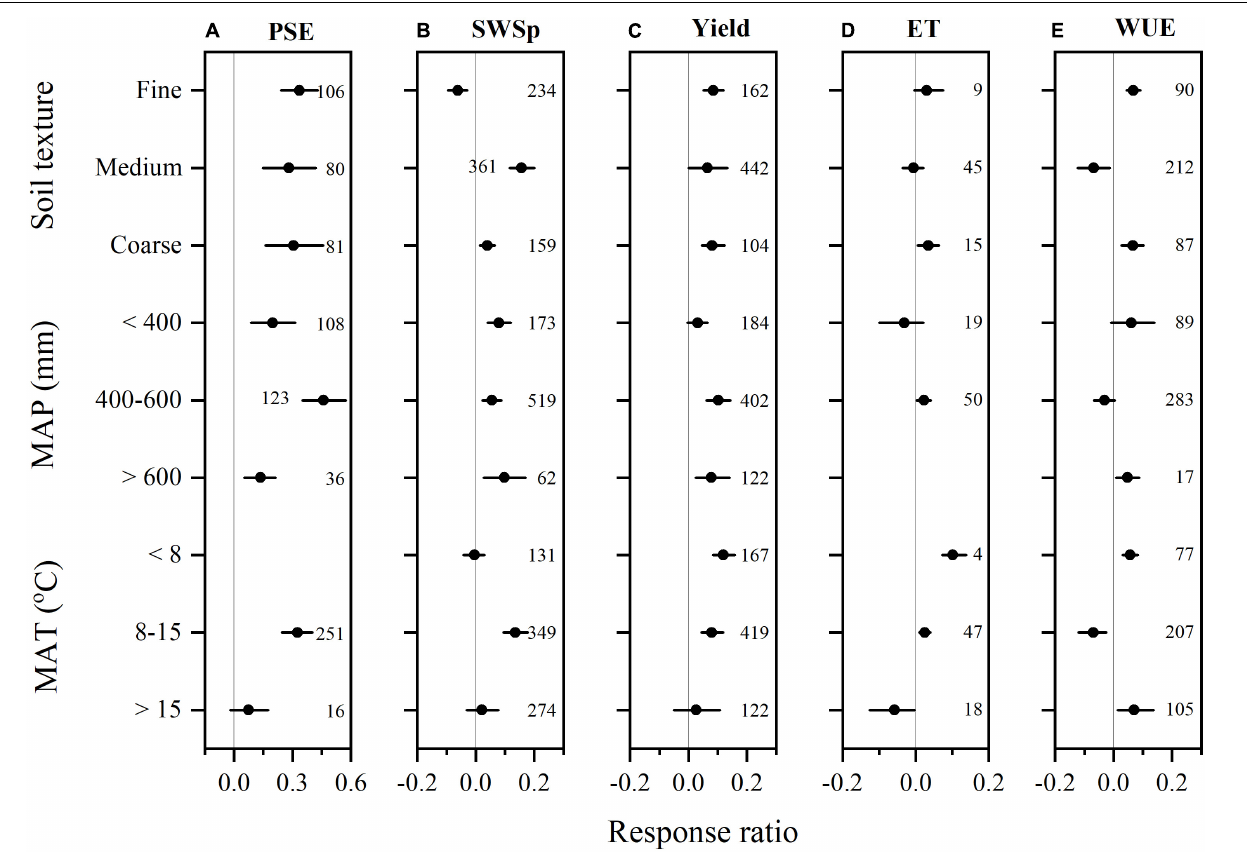
FIGURE 3 | The mean response ratios of precipitation storage efficiency (PSE, A ), soil water storage at wheat planting (SWSp, B ), winter wheat grain yield (C) , evapotranspiration (ET, D ), and water use efficiency (WUE, E ) to conservation tillage methods during fallow period compared to conventional tillage and their bootstrapped 95% confidence intervals (Horizontal line) as affect by soil texture, mean annual precipitation (MAP), and mean annual air temperature (MAT). The reference line (RR = 0) specifies no variation between conservation tillage and conventional tillage. Numbers accompanying the bootstrapped 95% confidence intervals designate the number of observations for